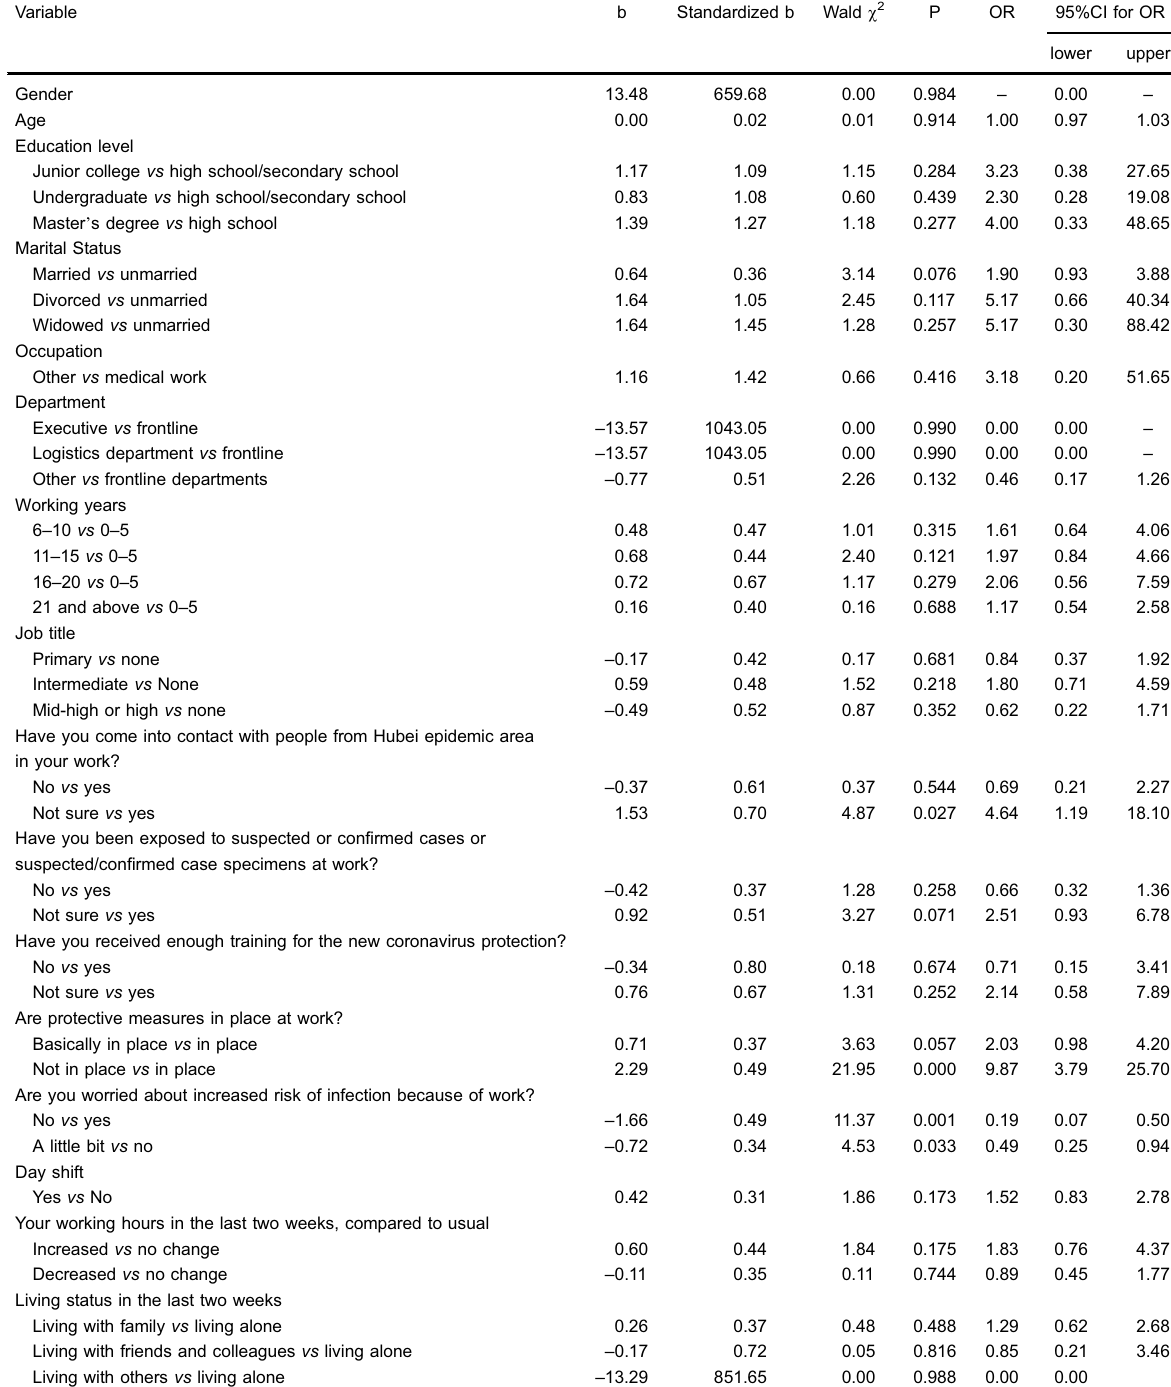
Table 1. Univariate logistic regression analysis of factors associated with anxiety in healthcare workers during the COVID-19 pandemic. Variable b Standardized